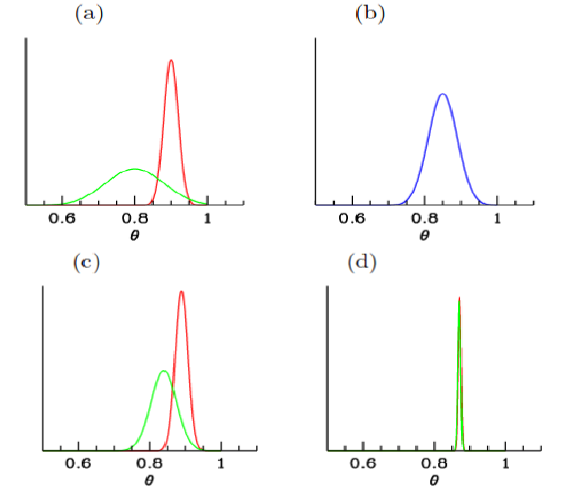
Figure 3. Converging views in Bayesian inference (taken from Reference [5]). A and B have different I i ) for a value θ (panel ( a )). Then, they observe one datum with an apparatus subject to priors P ( θ | a Gaussian noise and they obtained a likelihood L ( θ ; HI ) (panel ( b )), after which their posteriors P ( θ m 1 ) are obtained (panel ( c )). After observing 100 data, it can be seen that both posteriors are | practically indistinguishable (panel ( d